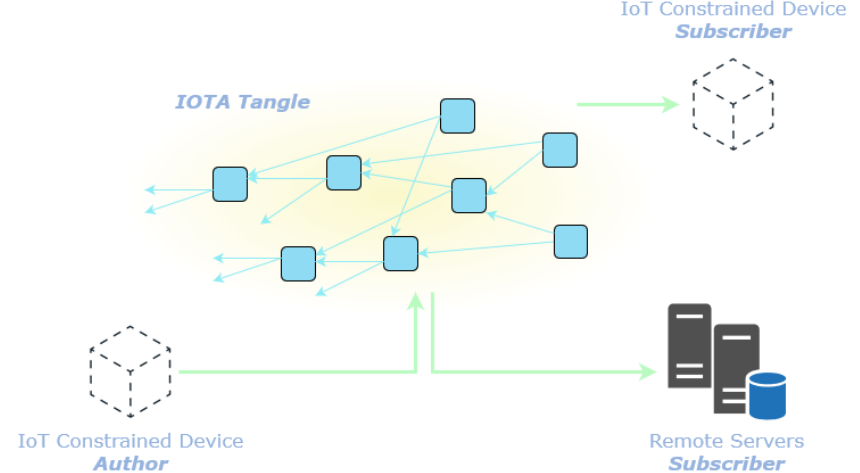
Figure 1. High-level system architecture. The IoT constrained devices act as Authors producing data and transmitting it to the Tangle. The Subscribers are either constrained or not-constrained devices that access the Tangle to retrieve the